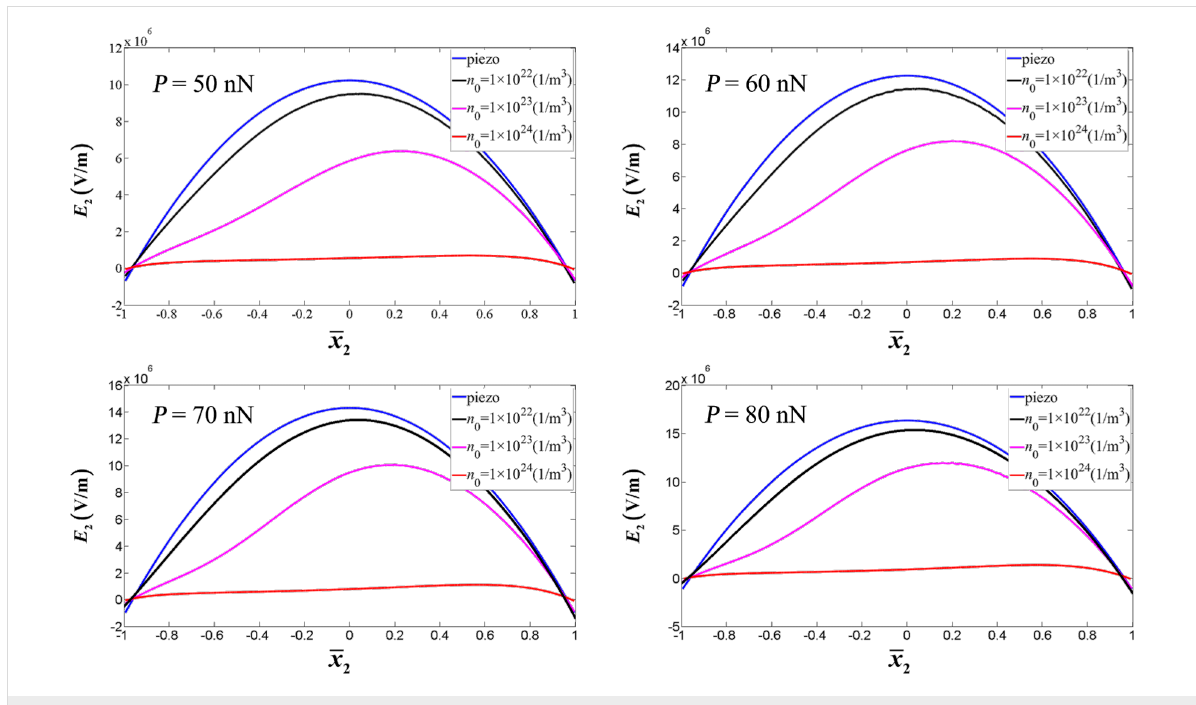
Figure 5: Effect of initial carrier concentration n 0 on the electric field E 2 along the x 2 -axis.